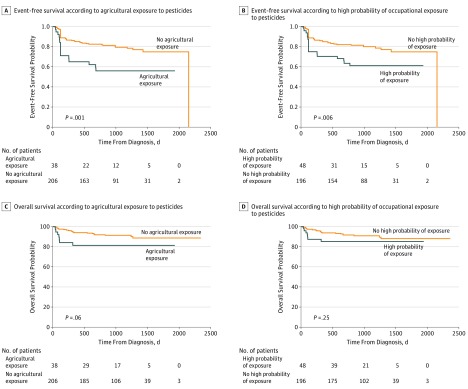
Event-Free and Overall Survival